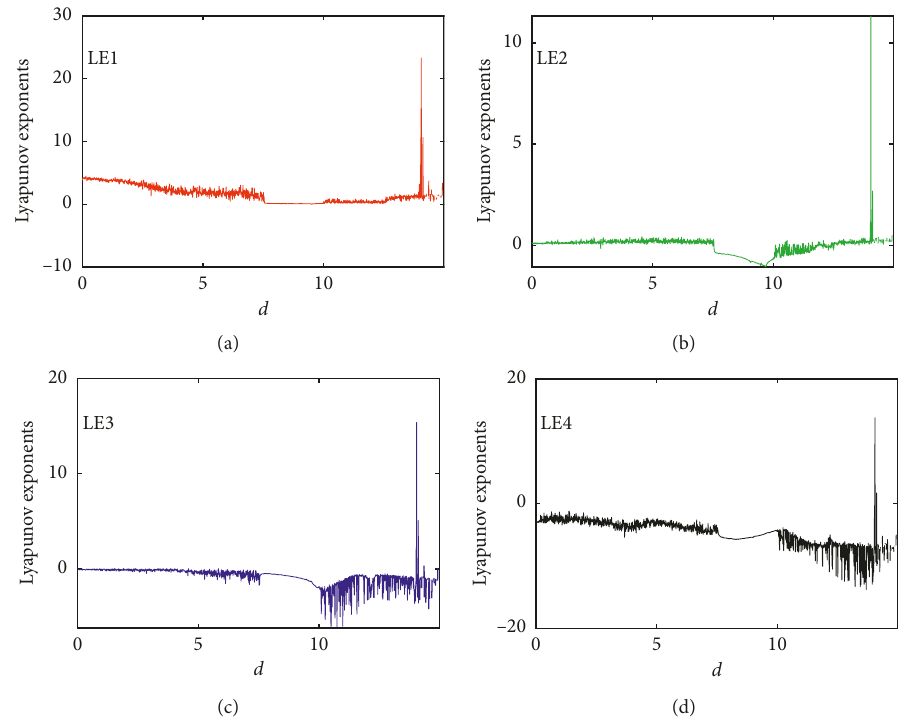
Figure 3: Lyapunov exponents’ spectrum for increasing parameter d (the fifth LE is out of plot).